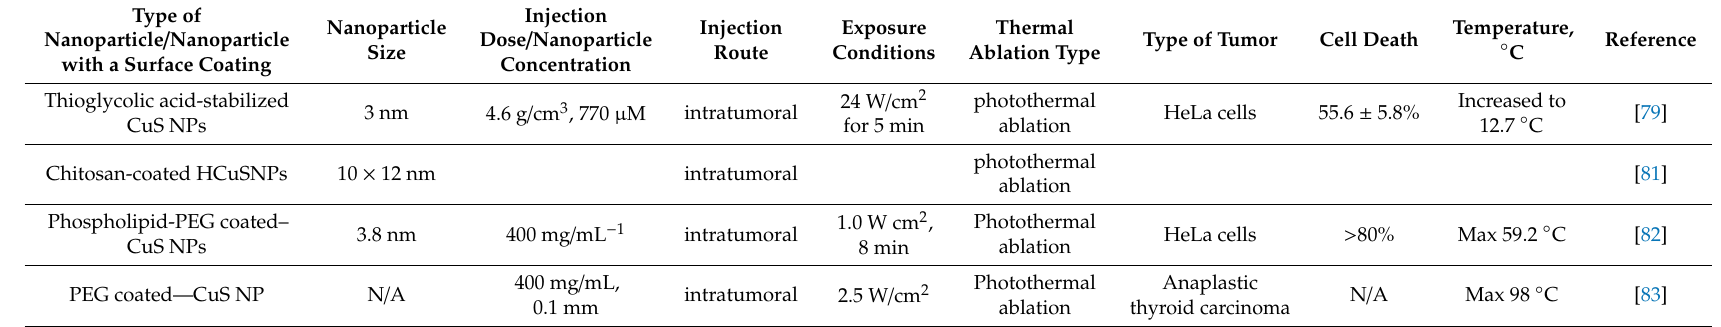
Table 3. Summary of Cu-based nanoparticles application in the thermal ablation of cancer (CuSNPs: hollow copper sulfide